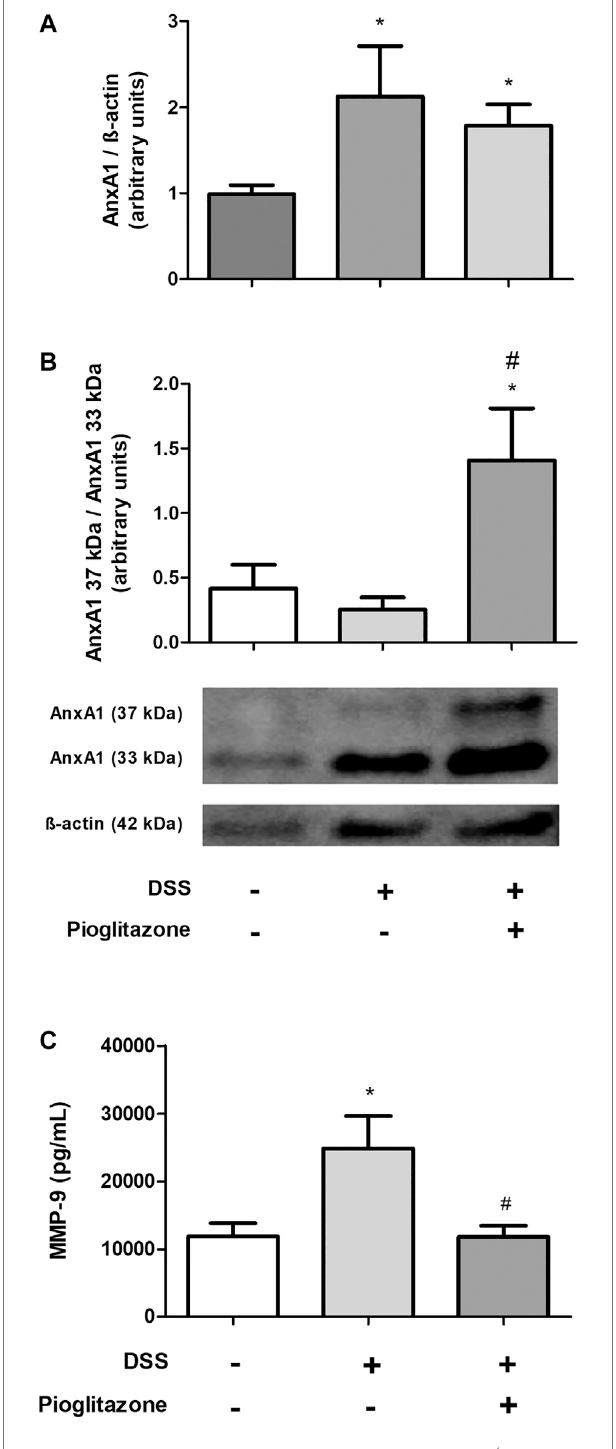
FIGURE 4 | Cleaving of AnxA1 in colon tissue. Wild type and AnxA1 − / − mice wereeuthanizedattheendoftheexperimentalmodel;largeintestineswereharvested and protein homogenates were prepared; expression and cleaving of AnxA1 were assessedvia WesternBlotting (A,B) andMMP-9expressionwasassessedvia ELISA (C) .* p < 0.05incomparisontothecontrolgroup; # p < 0.05incomparisonto the DSS-treated group. Data were statistically analyzed using One-Way ANOVA followed by Tukey ’ s post-test ( n (cid:2) 6). Results are expressed as mean ± SE.